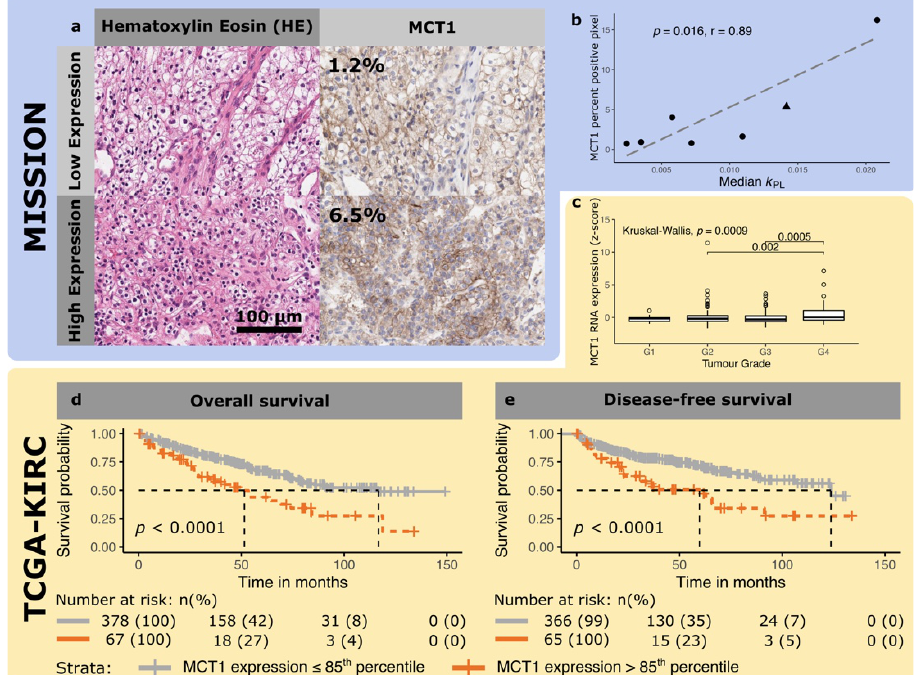
Figure 4. Representative micrographs of a clear cell renal cell carcinoma with high and low expres- sion of MCT1. ( a ) The left panels show a hematoxylin and eosin stain, and the right panels the corresponding immunohistochemical stain for MCT1 on an adjacent tissue slice. ( b ) Correlation between MCT1 IHC expression and k PL in the patient dataset imaged as part of this study (MISSION, dots represent ccRCC, the triangle the liposarcomas) ( c ) Box plot comparing z-transformed MCT1 expression as a function of histological tumor grade from a Cancer Genome Atlas dataset (TCGA- KIRC, yellow). ( d ) Kaplan–Meier plots for the association of MCT1 expression with overall and ( e ) progression/recurrence-free survival using an expression cut-off at the 85th percentile in the TCGA- IRC dataset. MCT1 expression was significantly associated with overall and progression/recur- rence-free survival.